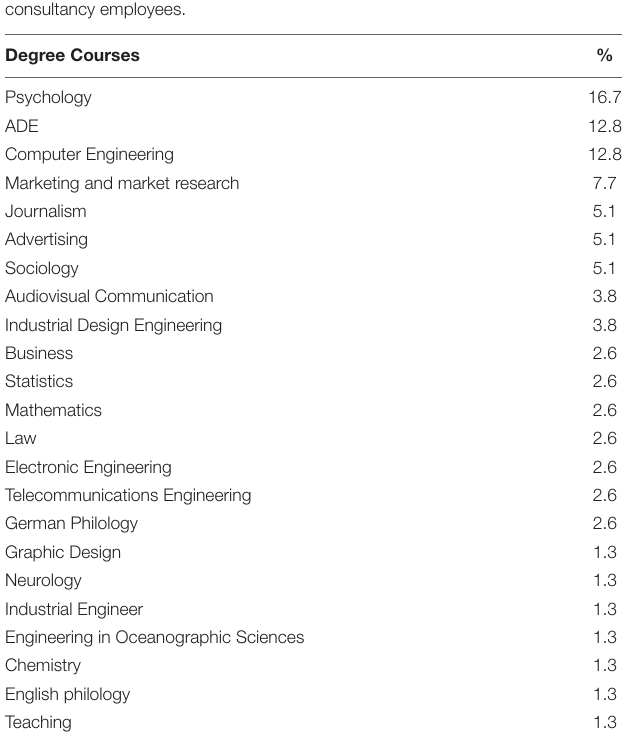
TABLE 3 | Representation of university degrees by specialty in consultancy